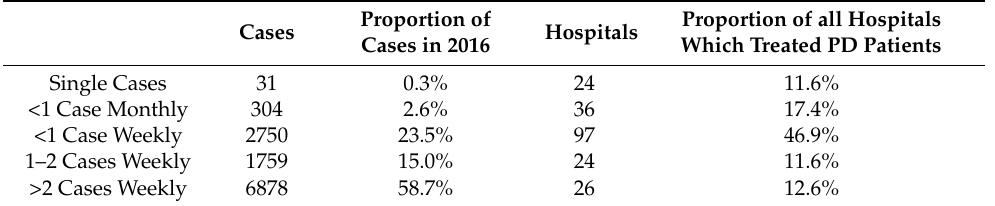
Table 7. Number of cases per year and hospitals for PD-MCT in PD (ICD G20–G23) grouped into classes for the year